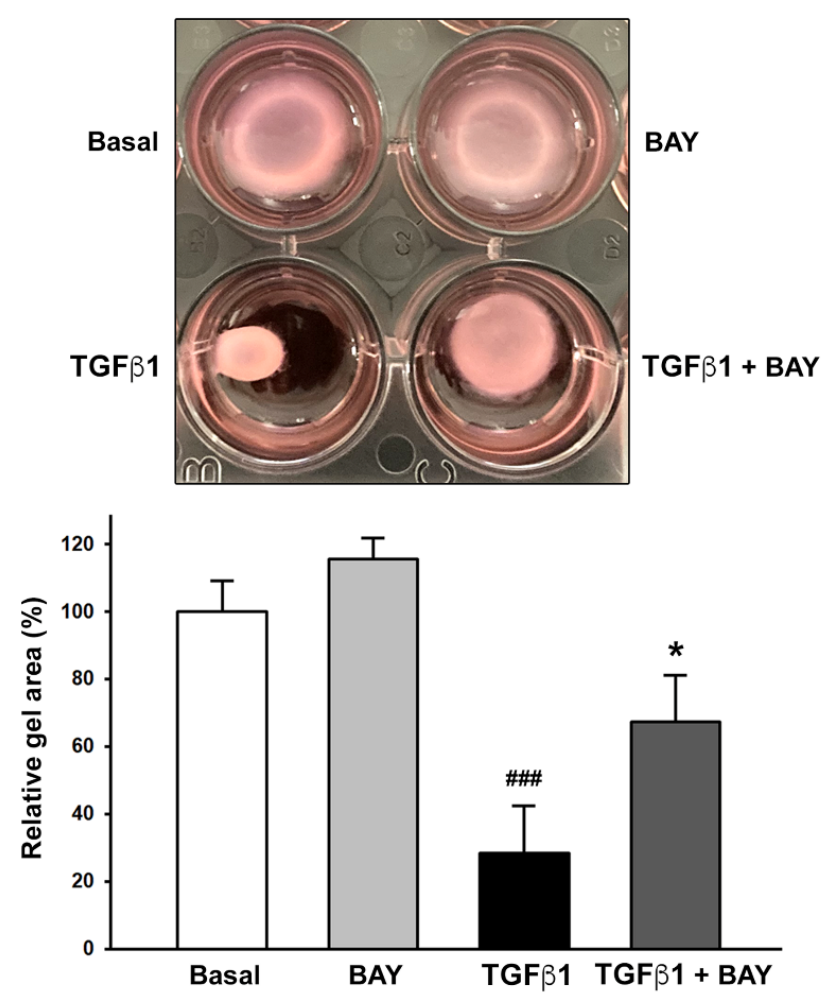
Figure 8. Soluble guanylate cyclase stimulation with BAY 41-2272 significantly reduces TGF β 1- induced contractile ability of human keratocytes evaluated by collagen gel contraction assay. Each experimental point was performed in triplicate for the five cell lines. Bars represent the mean ± SEM of gel sizes expressed as a percentage of that observed with cells at the basal condition; ### p < 0.001 vs. basal condition, * p < 0.05 vs. TGF β 1 alone (Tukey’s test). SEM, standard error of the mean; TGF β 1, transforming growth factor β 1.